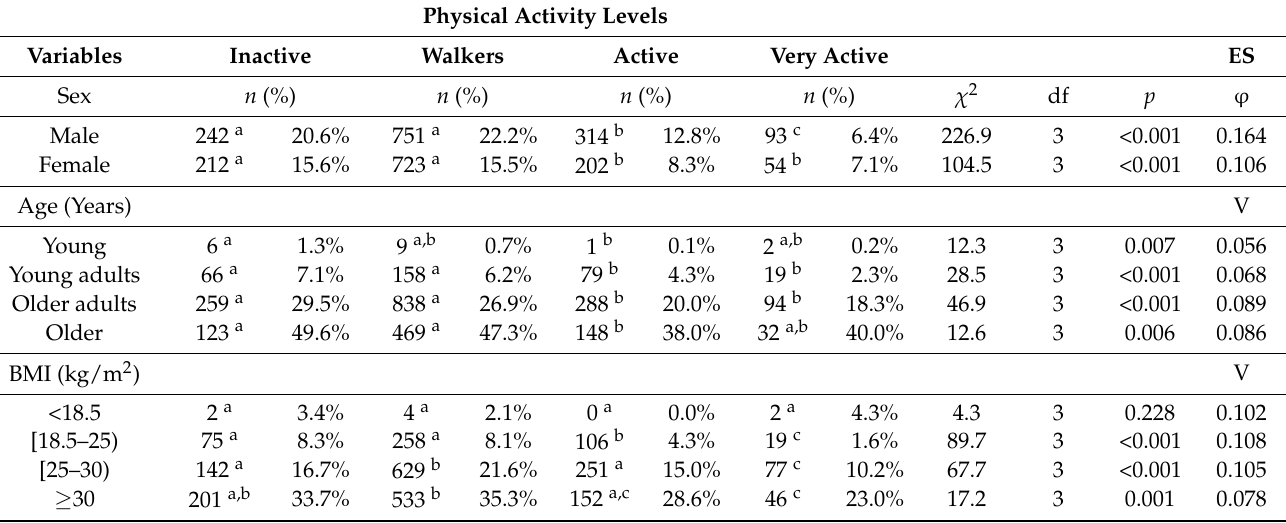
Table 5. Prevalence of use of antihypertensives by physical activity level and: sex, age and BMI. Physical Activity